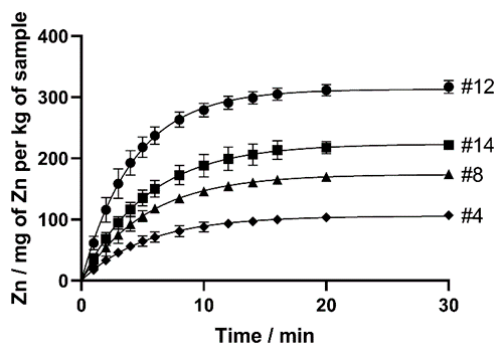
Figure 2. Kinetic profiles of bioaccessible Zn obtained for samples #4, #8, #12, and #14. Sample number is adjacent to the respective